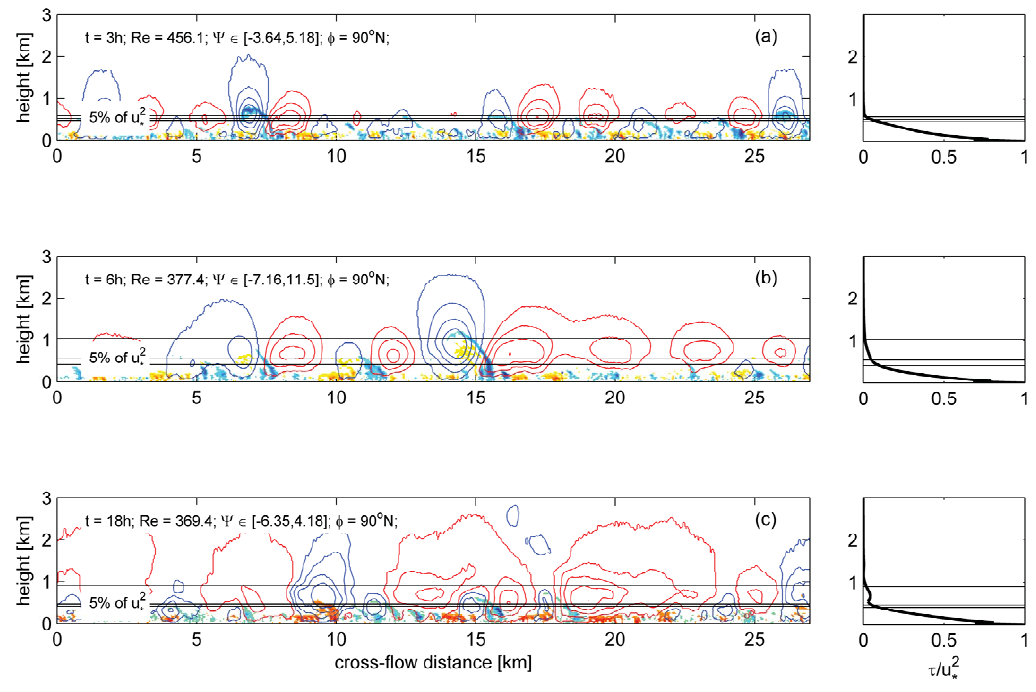
Fig. 10. Cross-flow sections ( yz planes) of the instant flow patterns in WE-EBL at 90 ◦ N. The panels are composed similarly to Fig.